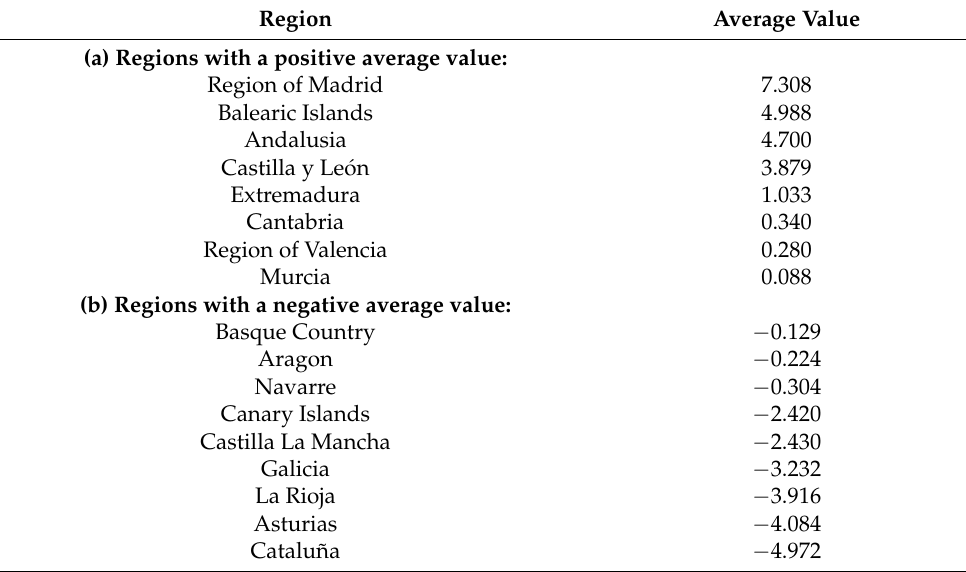
among Autonomous ij